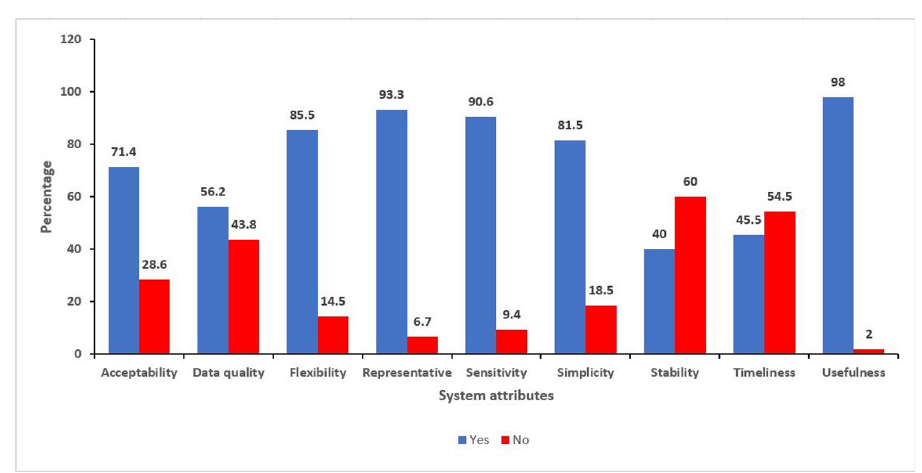
Fig 6. Distribution of respondents’ perception on FCT COVID-19 surveillance system